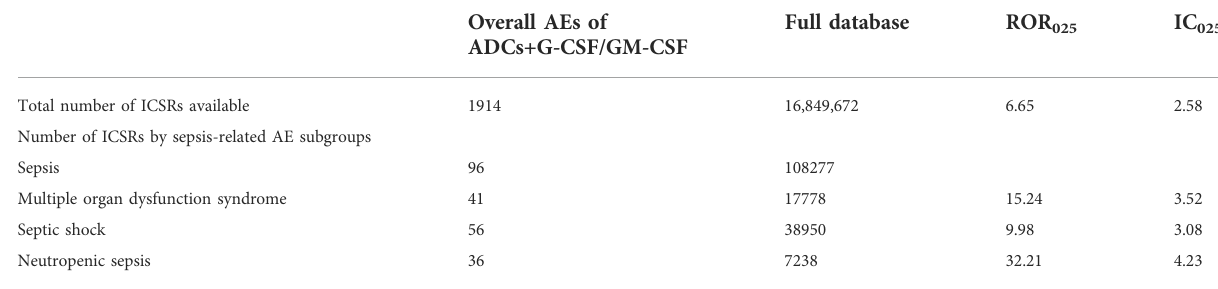
Overall AEs of Full database ADCs+G-CSF/GM-CSF